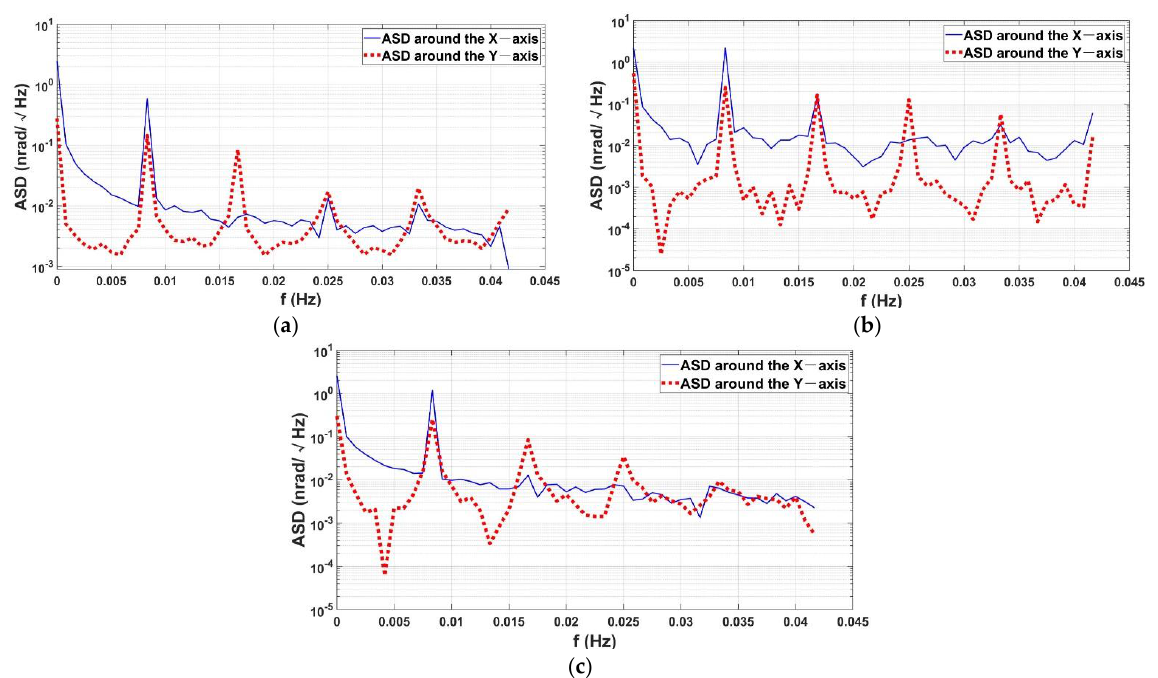
Figure 7. Amplitude spectral density corresponding to different heating directions.